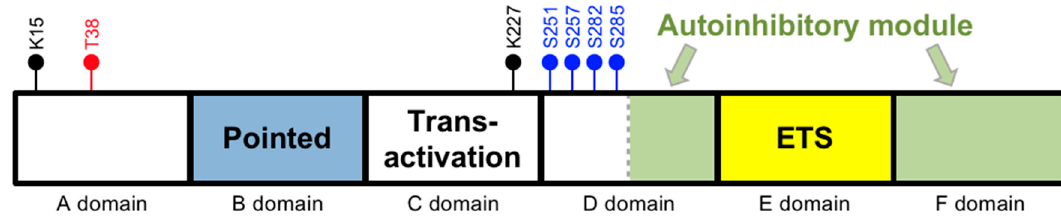
Figure 1. Domains of the most abundant isoform of ETS-1. Black circles are the lysine (K) sumoylation sites. Blue circles are the Ca 2+ -dependent serine (S) phosphorylation sites. The red circle is the Ras-dependent threonine (T) phosphorylation site. Note that the schematic domain lengths are not proportional to the numbers of amino acids within each domain.